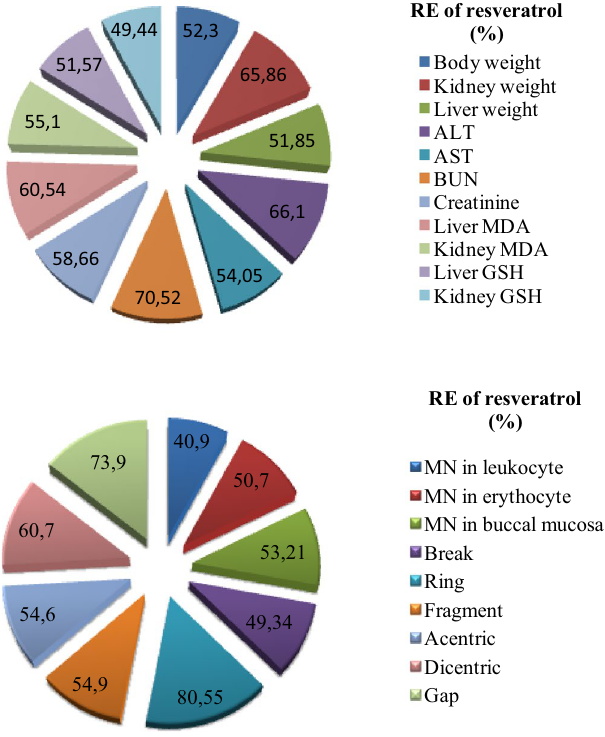
Figure 6. Recovery effects of 20 mg/kg resveratrol against AFB 2 toxicity on physiological, biochemical and genotoxic